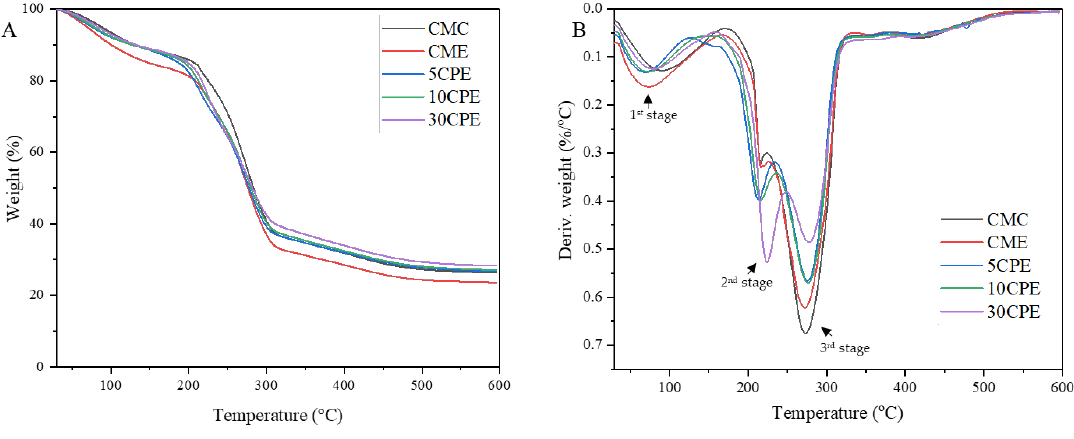
Figure 7. Thermal properties; TG ( A ) and DTG ( B ) curve of films. Table 5. Weight loss at stages of thermal degradation and maximum degradation temperature of